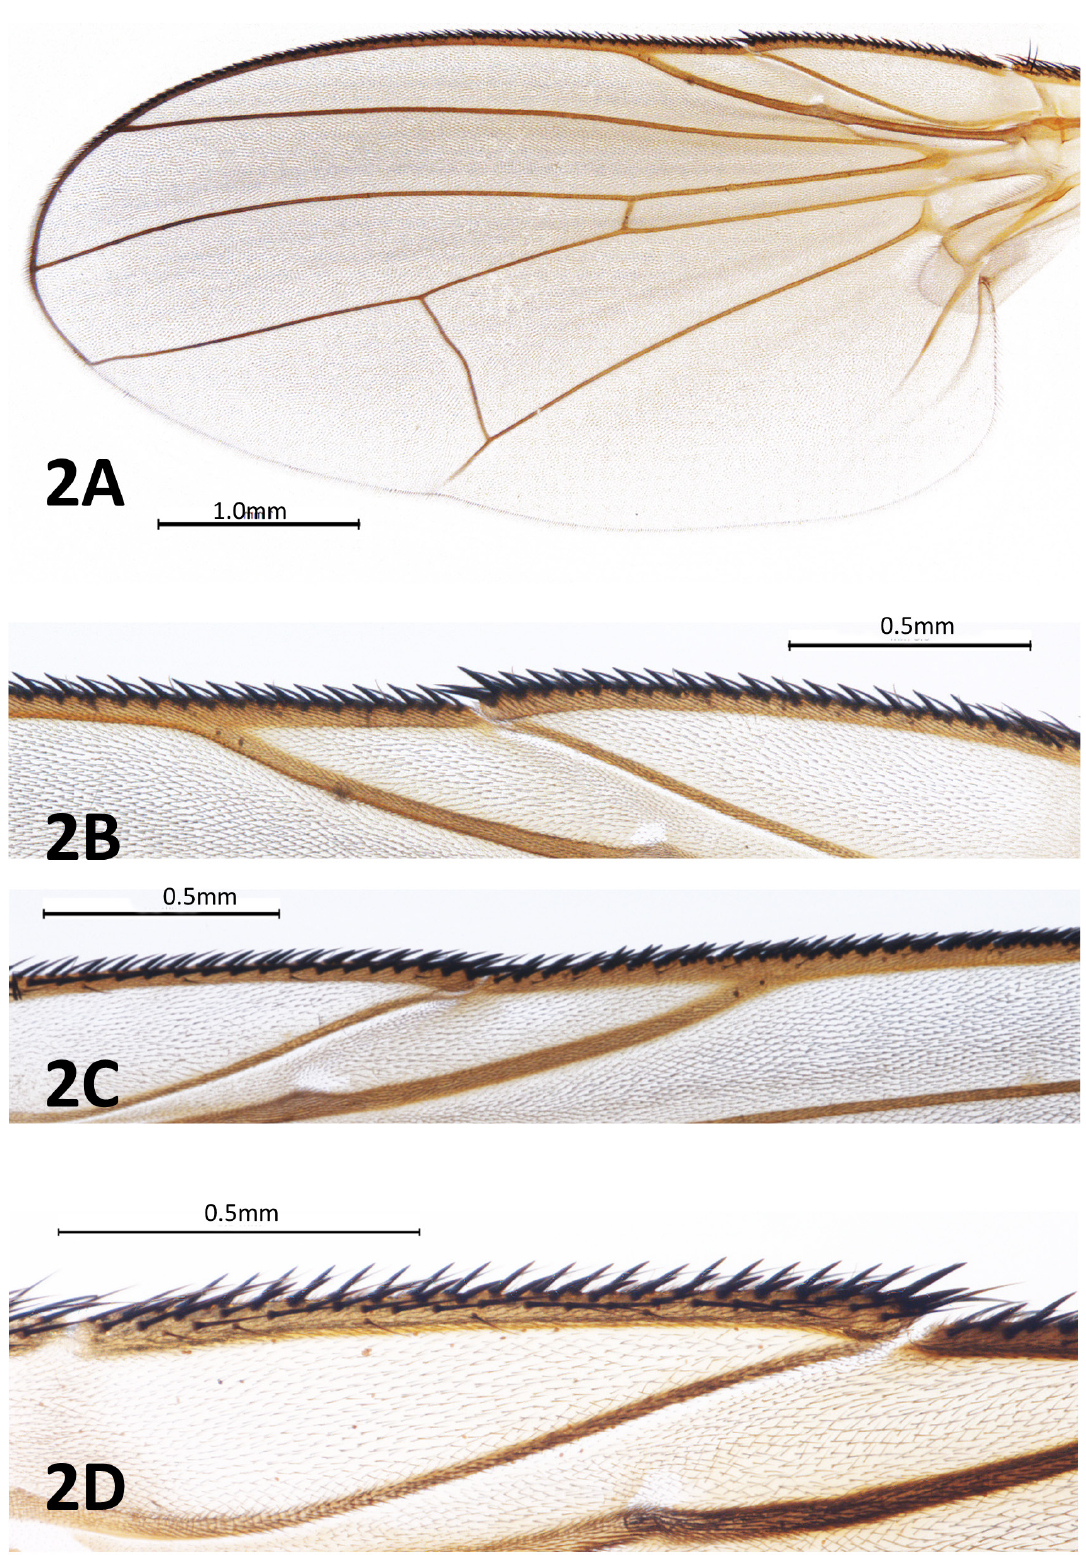
Fig. 2. ♀♀ of Fanniidae Schnabel & Dziecicki, 1911. A . Fannia fuscula (Fallén, 1825), wing, ventral view. B . Same, detail of wing showing CS1‒3, ventral view. C . Same, detail of wing showing CS1‒3, dorsal view. D . Piezura pardalina Rondani, 1866, detail of wing showing CS1 in dorsal